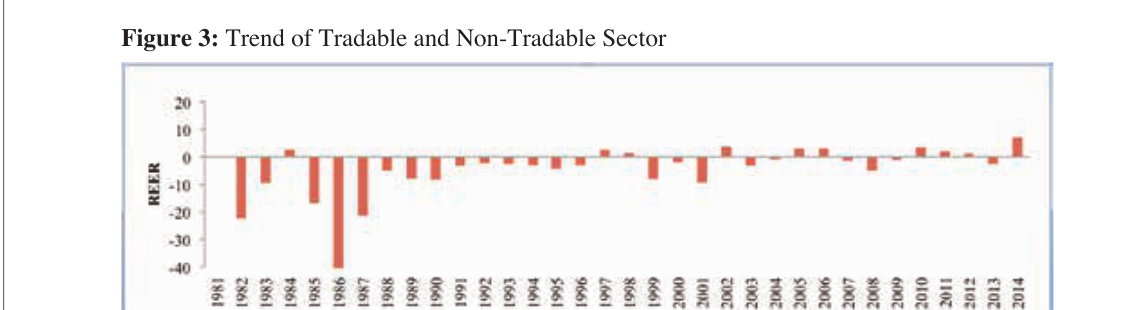
Figure 3: Trend of Tradable and Non-Tradable Sector